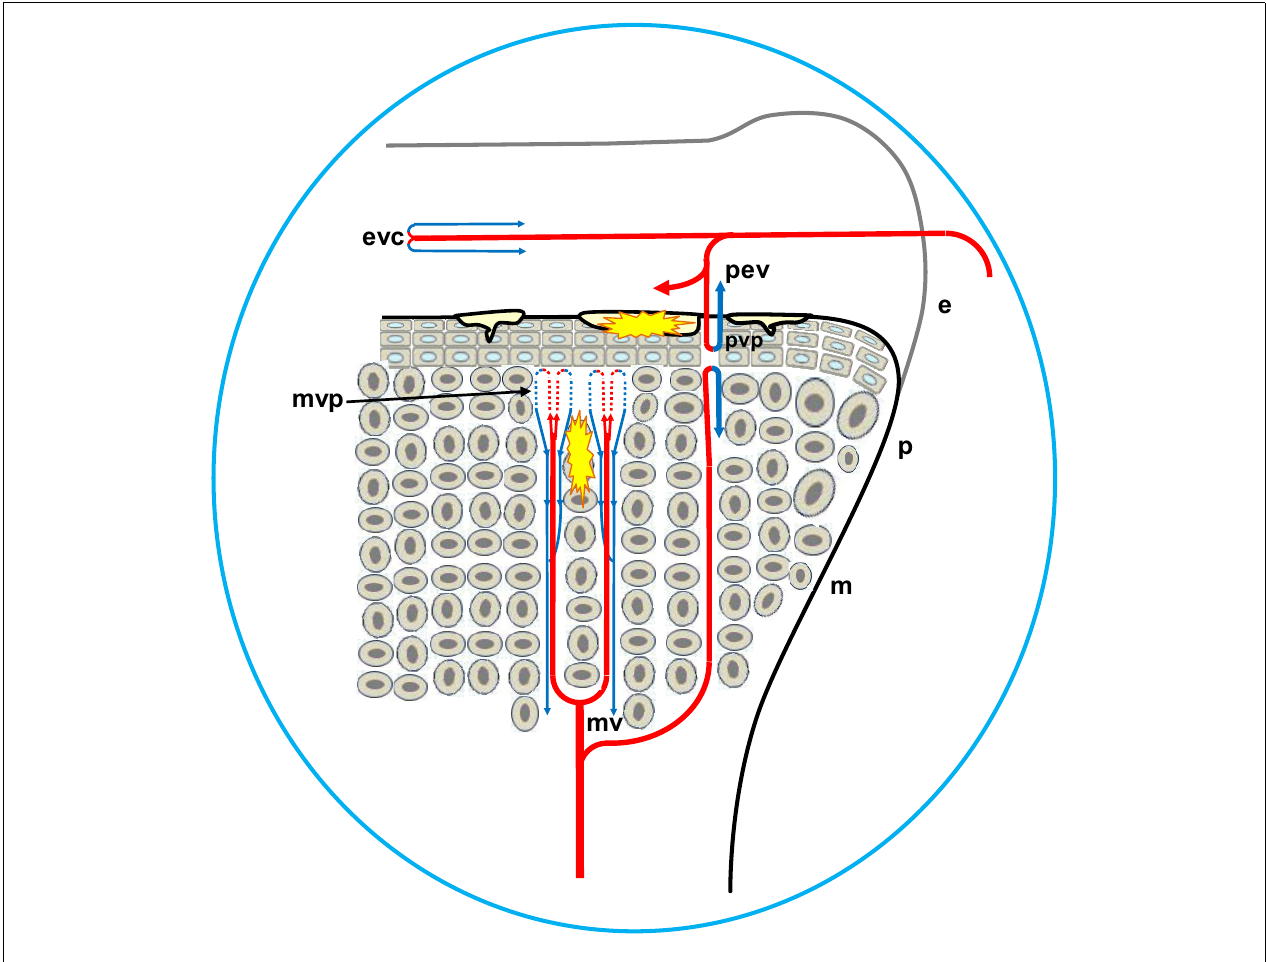
exit the bloodstream through the fenestrated endothelium at the tips of the metaphyseal vascular plexus.The extravasated bacteria may adhere directly to the cartilage matrix, they colonize osteochondrotic clefts and zones of necrosis, and they form obstructive emboli in the metaphyseal vasculature. Similar hairpin bends and fenestrated capillary epithelia have been reported for the terminal epiphyseal vascular complex (evc), as well as for the terminus of penetrating epiphyseal vessels (pev) and the penetrating vascular plexus